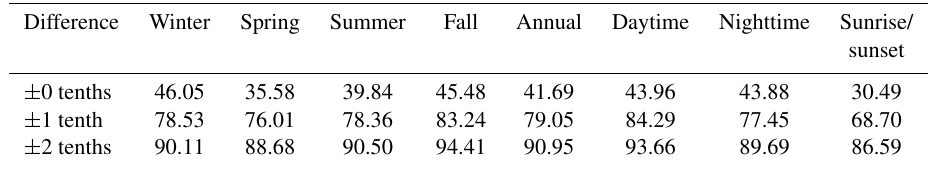
Table 4. Concordance frequency (%) according to the difference between the observed (DROM) and calculated (ACOS) cloud cover for the test